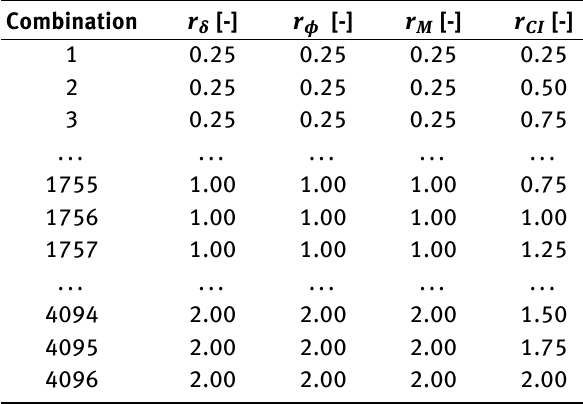
Table 4: The possible combinations by considering eight different exponents r p for each response